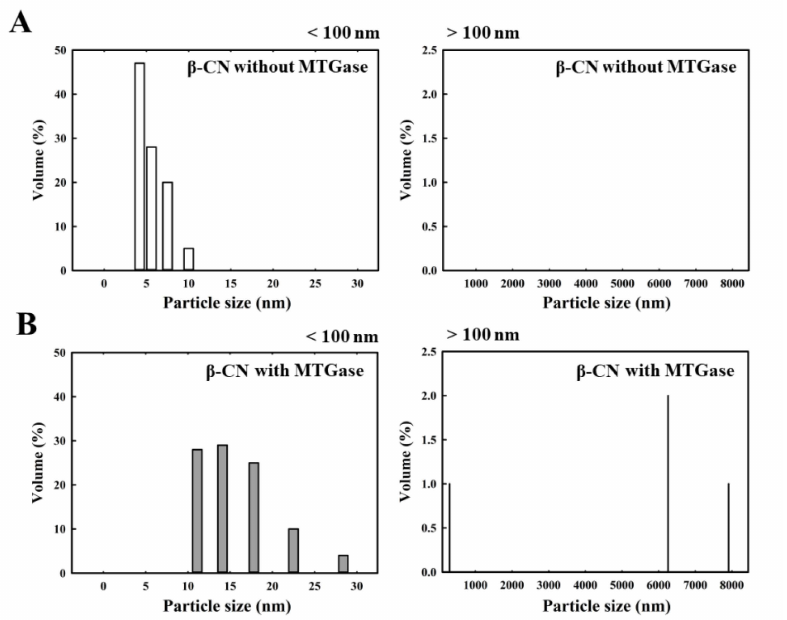
Figure 6. Changes in the particle size distribution of β -CN (2 mg) without / with 2.0 units / mL MTGase at 30 ◦ C for 3 h. ( A ) β -CN without MTGase (below 100 nm / above 100 nm); ( B ) β -CN with MTGase (below 100 nm / above 100 nm). The z-average diameter of the colloidal dispersions was measured using a nanoparticle analyzer. Samples were diluted with a bu ff er (pH 6.8) prior to measurements to avoid multiple scattering e ff